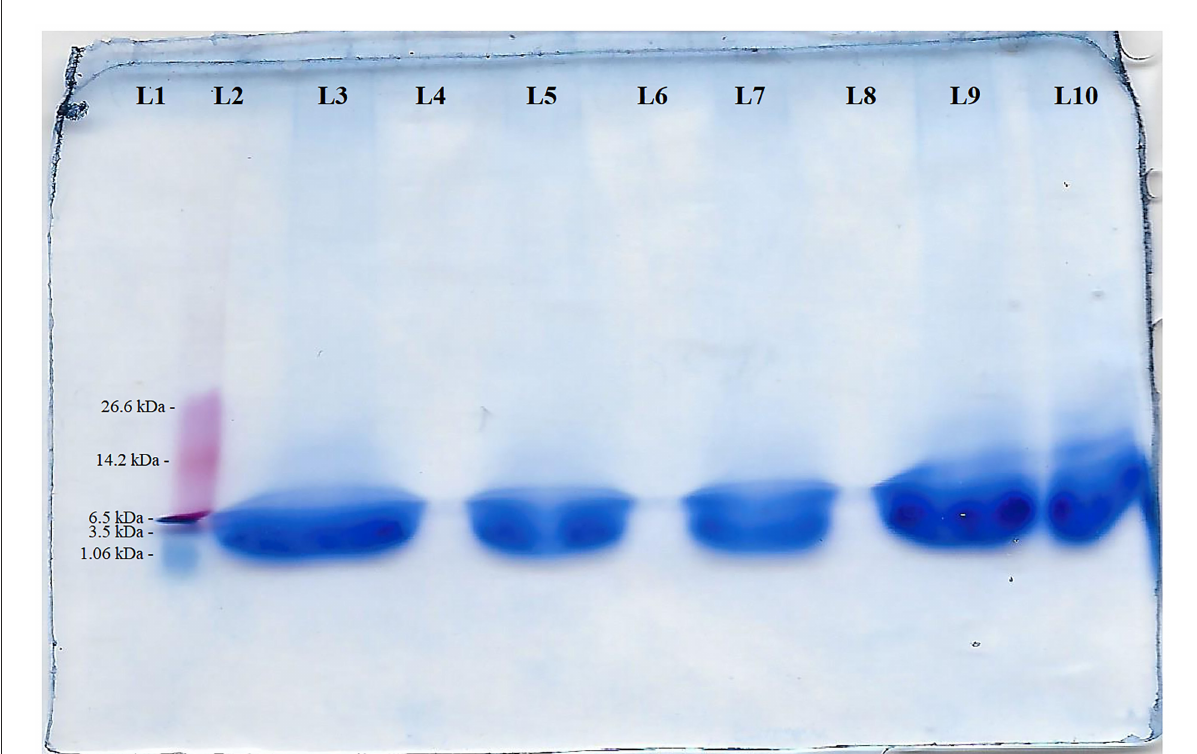
FIGURE3 SDS-PAGE of squid by-product hydrolysate in 10% resolving gel of SDS-PAGE of squid by-products hydrolyzed using bromelain for 4h. L1- Blank; L2- protein ladder (marker - 26.6 - 1.06 kDa from top to bottom); L3 - 17.33 µ g protein 15 µ l − 1 ; L4 - Blank; L5 - 11.55 µ g protein 15 µ l − 1 ; L6 - Blank; L7 - 7.70 µ g protein 15 µ l − 1 ; L8- Blank; L9 - 17.33 µ g protein 15 µ l − 1 , L10 - 11.55 µ g protein 15 µ l − 1